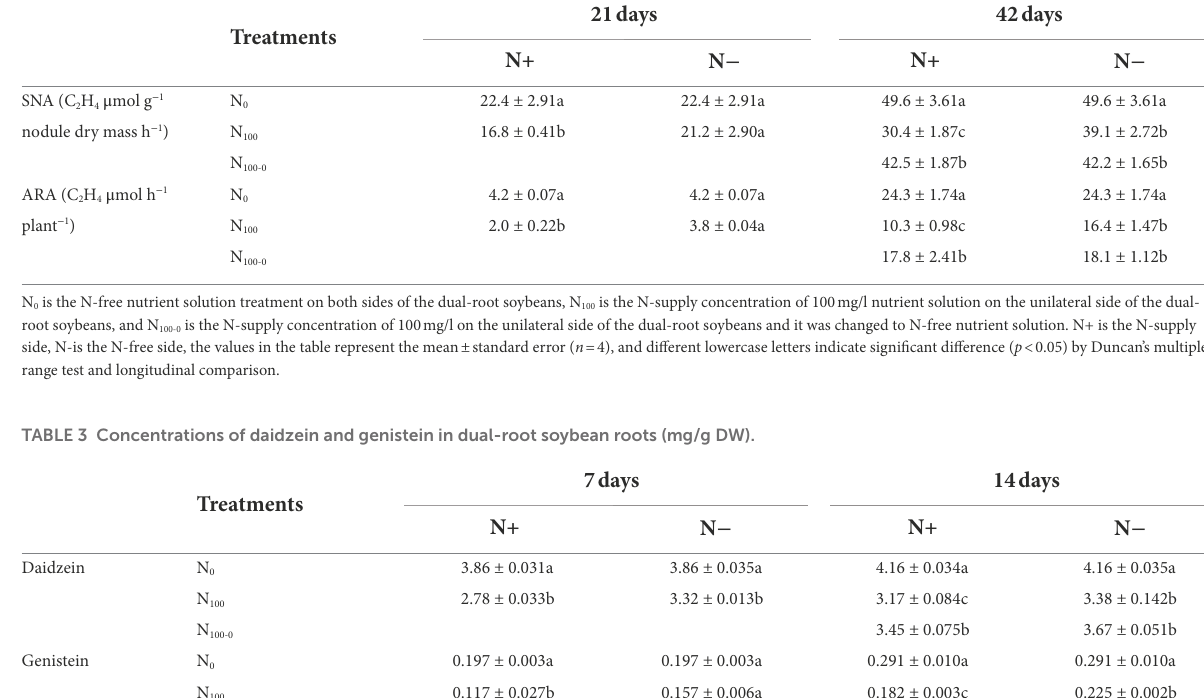
TABLE 2 Changes of nitrogenase activity in dual-root soybean nodules.